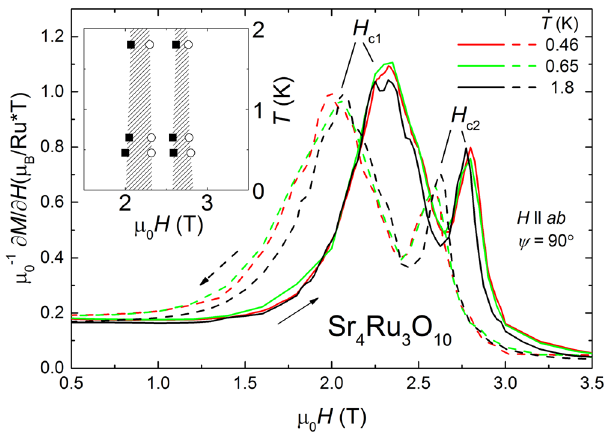
Figure 1. Field derivative of the magnetization ∂ ∂ M H / at 1.8 K, 0.65 K and 0.46 K with clear anomalies at two critical fields H c 1,2 . Solid lines show measurements during increasing field sweeps and dashed lines during decreasing field sweeps as labeled by arrows. The inset shows H − T phase diagram close to the MM transition with regions of hysteresis marked as striped